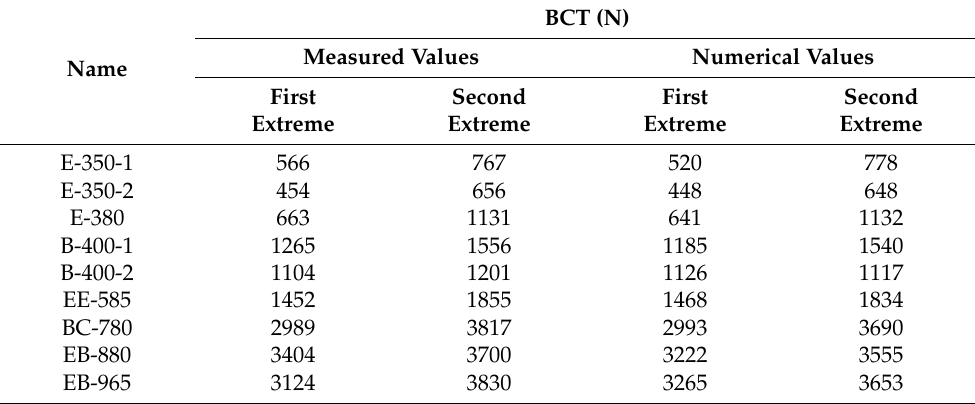
Table 4. Comparison of measured and numerically determined BCT values for various corrugated cardboard packaging.